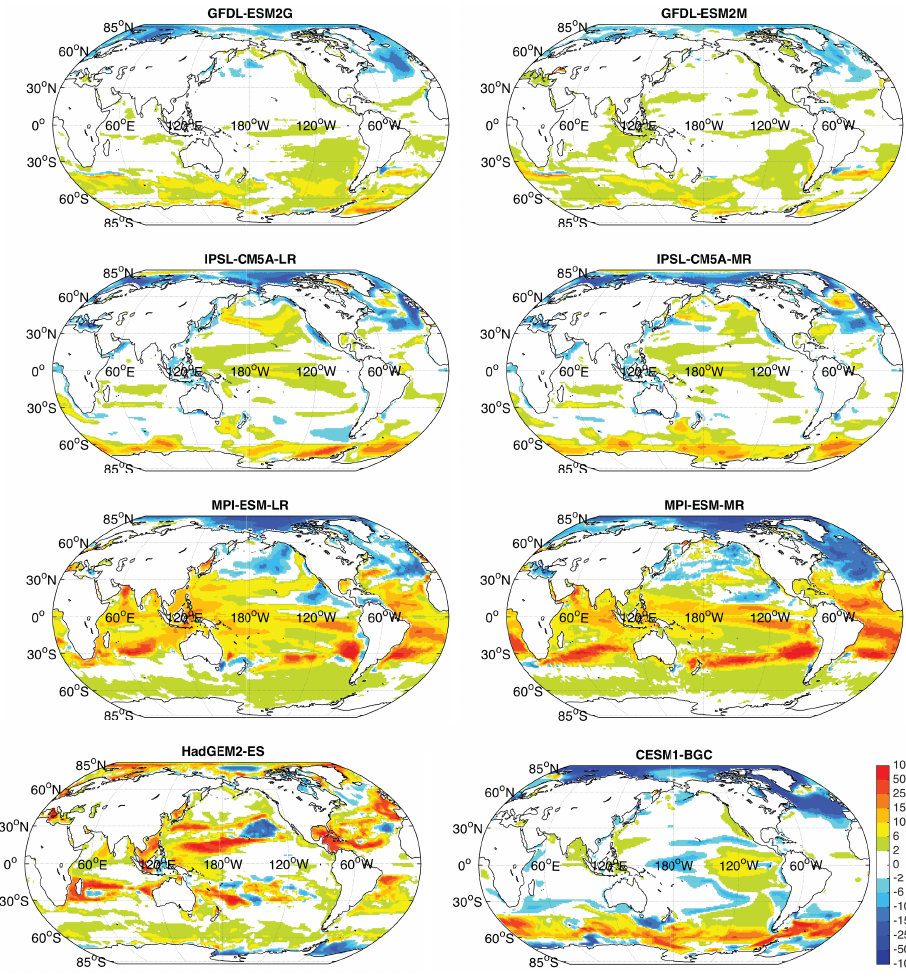
Figure 9. The percent change in NPP by diatoms between the 2090s and the